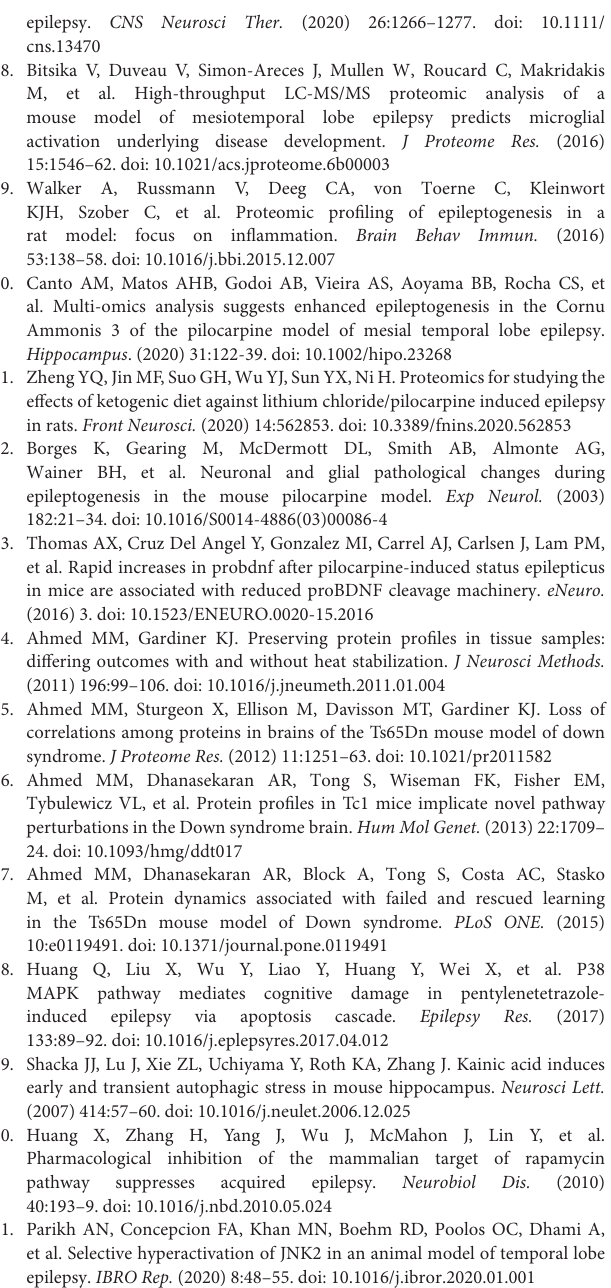
mice) were randomly assigned to a single treatment/time point group. Mice were given an intraperitoneal injection of scopolamine methyl bromide (1 mg/kg) 15min before the first pilocarpine injection to block the peripheral effects of pilocarpine. The initial dose of pilocarpine HCl (200 mg/kg) was followed, after 1h, by subsequent doses (100 mg/kg) given at 30min intervals. The onset of SE was defined as the appearance of repeated behavioral seizures (stage four or higher with at least one seizure being five or higher) according to a modified Racine scale. SE persisted for at least 90min. Control mice were given injections of saline at identical time intervals. After SE induction, mice were singly housed and given free access to water and moistened chow. Cohorts of 5 mice per group were sacrificed after SE, at 15min (onset), 1 and 6h, 1 and 5 days, and 2 weeks (red lines). Groups of saline-injected mice were sacrificed at the same time